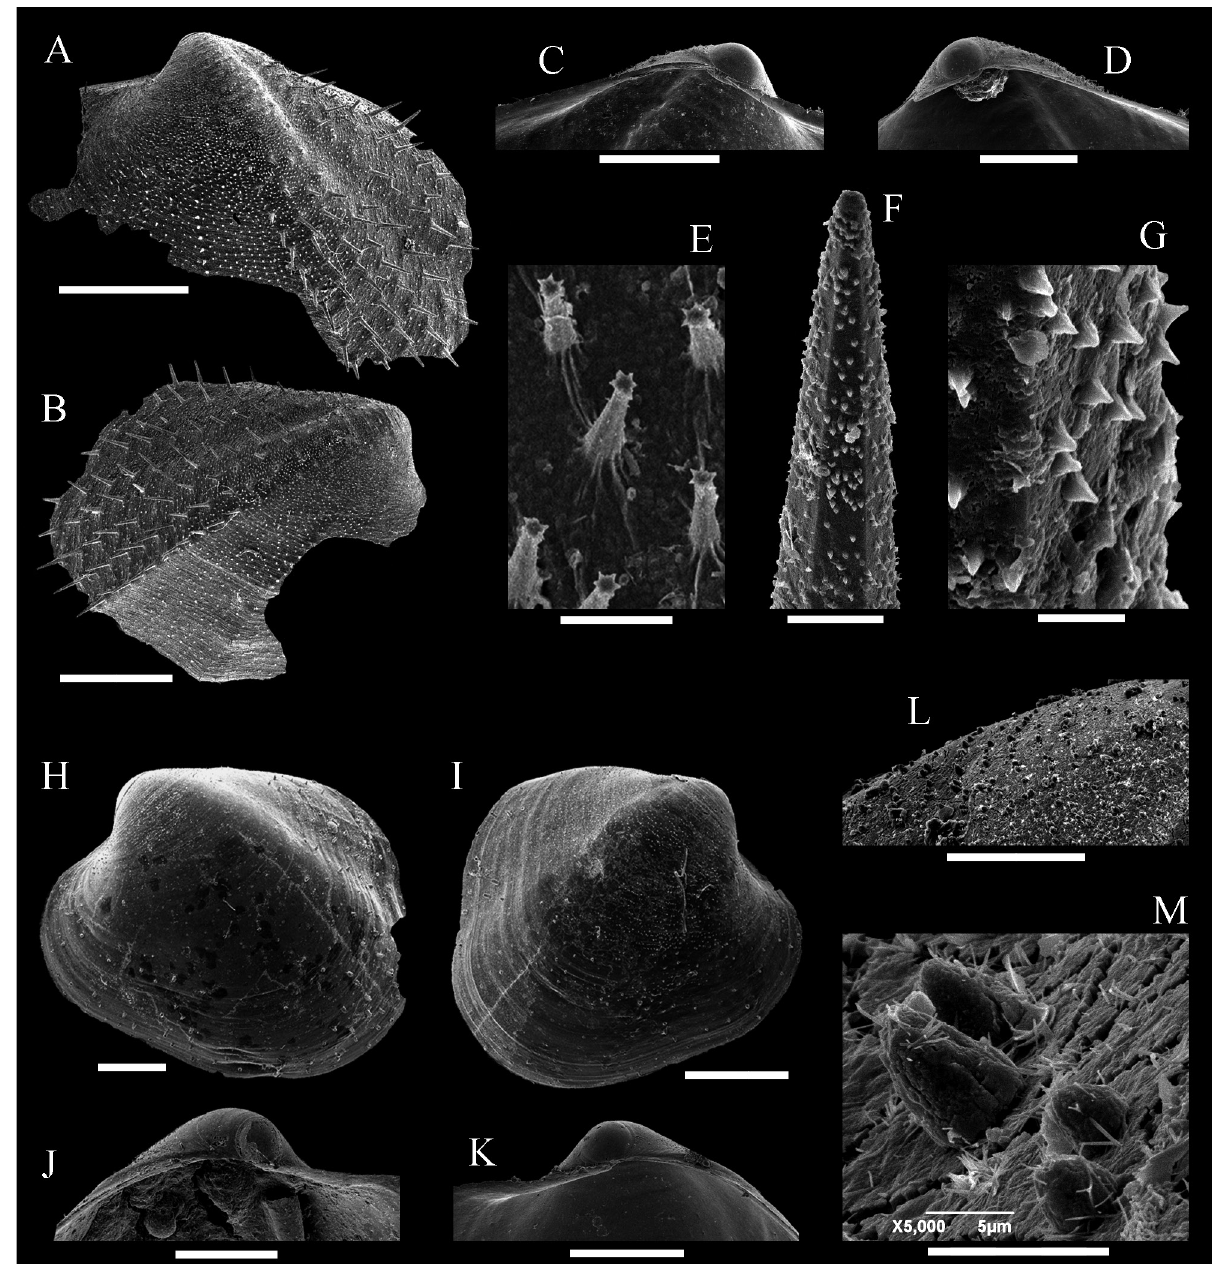
Fig . 2 . – Lyonsiella cf. formosa (Jeffreys, 1881), IBUFRJ 18134: A, B, external view, left and right valve respectively; C, D, hinge detail, left and right valve respectively; E, external surface detail; F, longer spine; G, longer spine detail. Lyonsiella pipoca n. sp. Holotype, IBUFRJ 18139: H, I, external view, left and right valve respectively; J, hinge detail, left valve, IBUFRJ 18139; K, hinge detail, right valve IBUFRJ 18140; L, external surface detail, IBUFRJ 18139; M, tiny pyramidal projections, IBUFRJ 18139. Scale Bars: G, 4 μm; M, 10 μm; F, 20